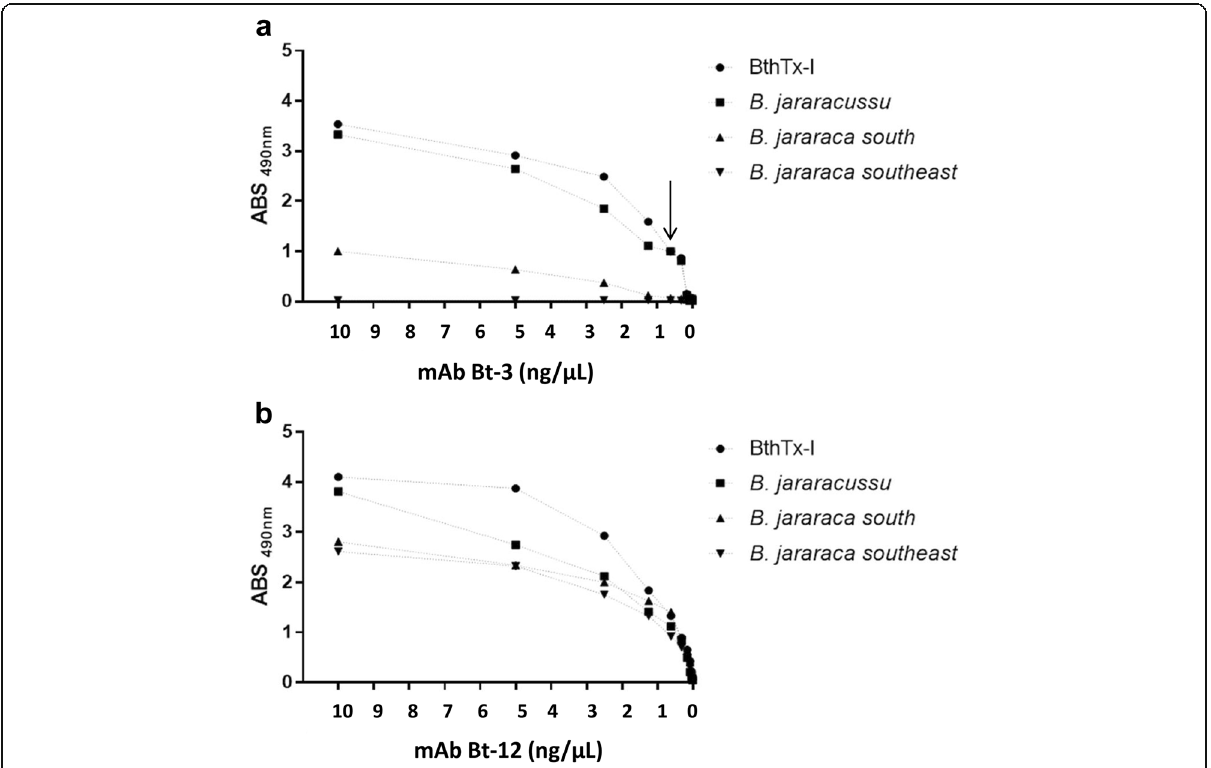
Fig. 4 Titration of monoclonal antibodies. A 96-well plate was sensitized overnight with one microgram of BthTx-I and venoms from B. jararacussu, southeastern B. jararaca and southern B. jararaca . The plate was then incubated with various concentrations of mAb and revealed with anti-mouse IgG labeled with peroxidase. The arrow in ( a ) shows the concentration of mAb Bt-3 (0.62 ng/ μ L) which recognizes BthTx-I and B. jararacussu venom. The venoms from B. jararaca from the south and southeast were not recognized. In ( b ), titration of mAb Bt-12. Given the reproducibility of the mAbs against BthTx-I, B. jararacussu, southeastern B. jararaca and southern B. jararaca venoms, only a representative result is showed for mAb Bt-3 (representing results